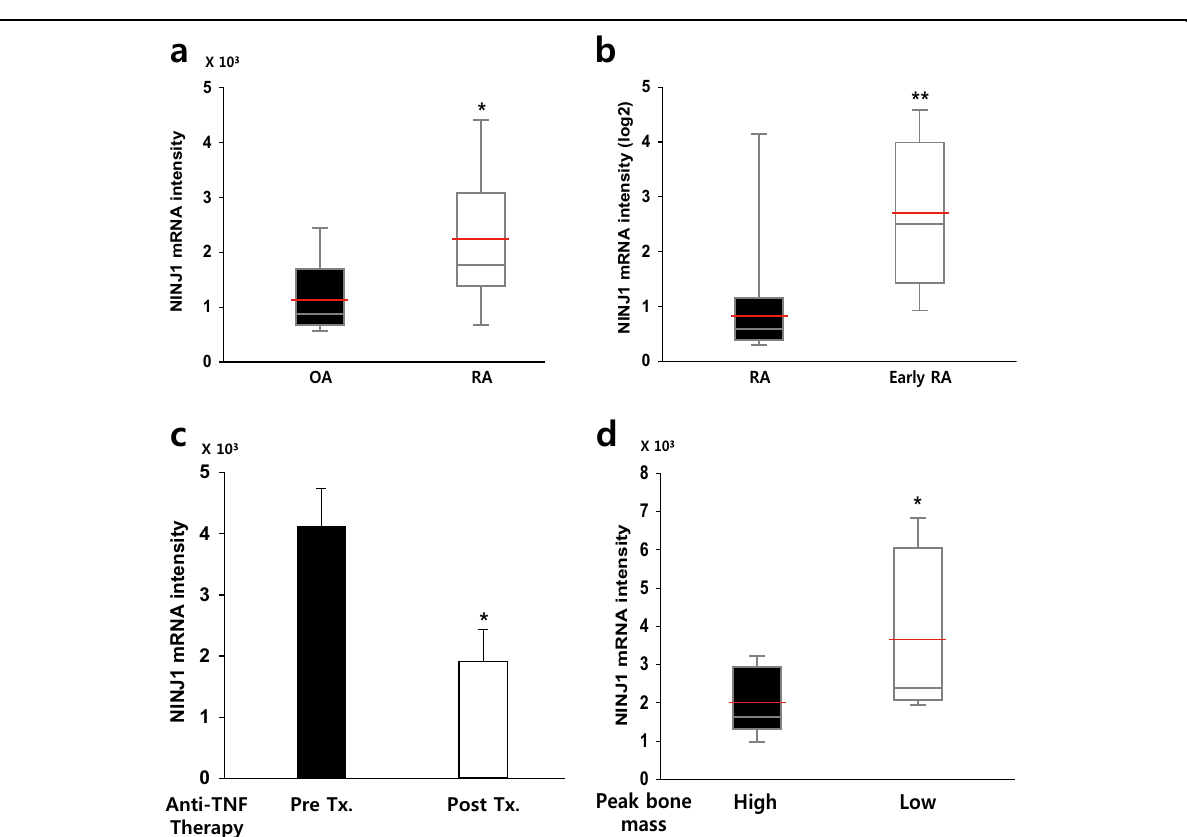
Fig. 8 The expression level of NINJ1 is correlated with bone disorders in humans. a – d Expression levels of NINJ1 mRNA were analyzed from the gene expression data sets GSE27390 ( a ), GSE1964 ( b ), GSE7524 ( c ) and GSE7158 ( d ) deposited in GEO. Red bars indicate the mean value. a Bone marrow-derived mononuclear cells were obtained from patients with osteoarthritis ( n = 10) or rheumatoid arthritis ( n = 9), and NINJ1 mRNA expression was analyzed. The data are shown in a median-quartile boxplot; * P < 0.05. b Comparison of NINJ1 expression in peripheral blood mononuclear cells derived from patients with rheumatoid arthritis ( n = 8) or early rheumatoid arthritis ( n = 15). The data are shown in a median- quartile boxplot; ** P < 0.01. c The change in NINJ1 mRNA expression in whole blood samples from rheumatoid arthritis patients following anti-TNF therapy was analyzed, and the data are shown as the mean ± SD ( n = 2); * P < 0.05. d The difference in NINJ1 mRNA expression in circulating monocytes derived from postmenopausal women with high ( n = 8) and low ( n = 7) peak bone mass was analyzed, and the data are shown in a median-quartile boxplot; * P < 0.05